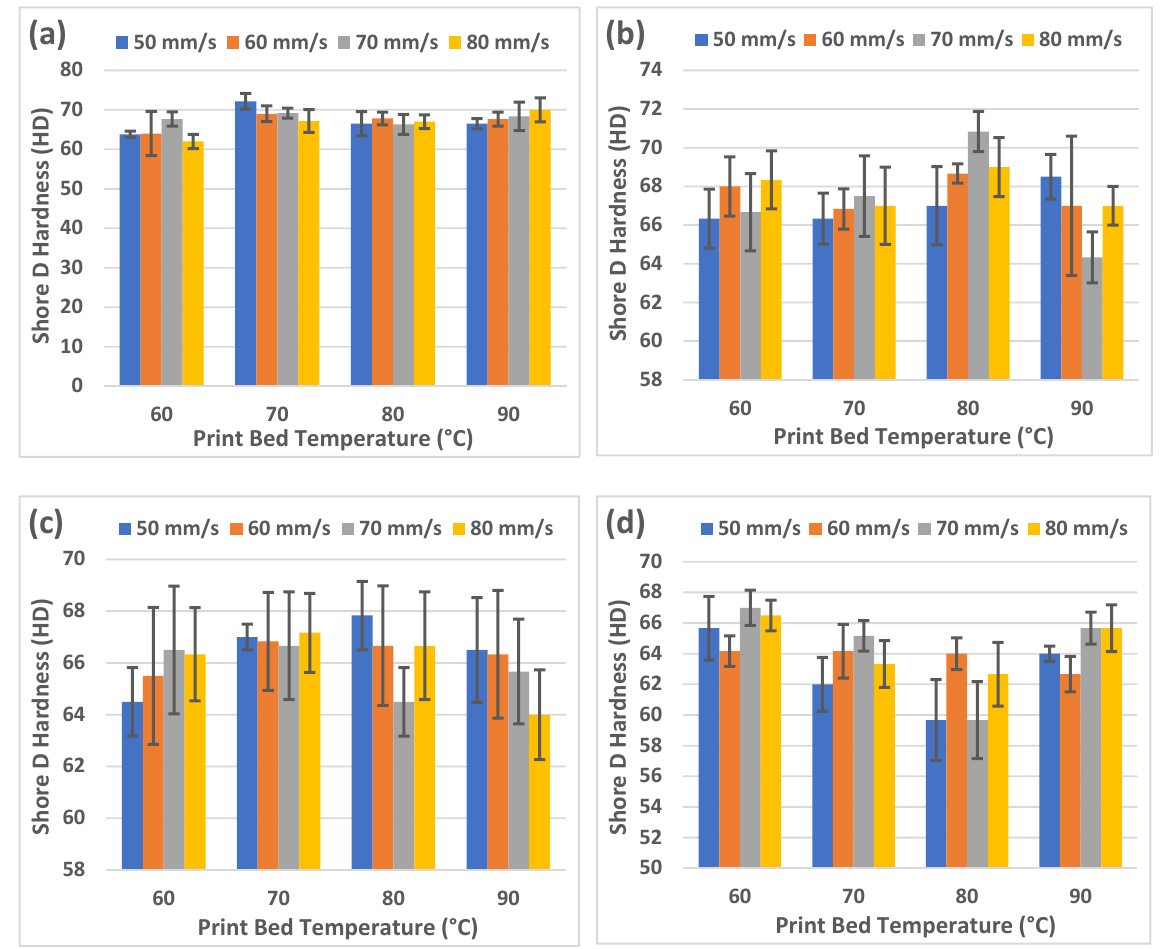
Figure 3. Results from hardness testing at different nozzle temperatures: ( a ) 180 °C; ( b ) 190 °C; ( c ) 200 °C; ( d ) 210 °C.